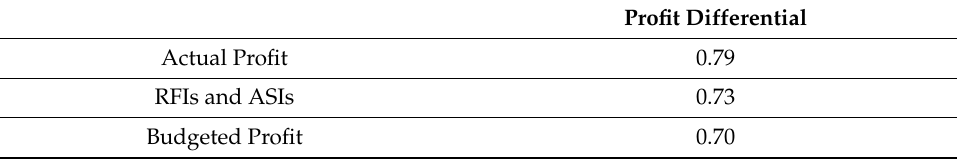
Table 8. Significant correlations for profit